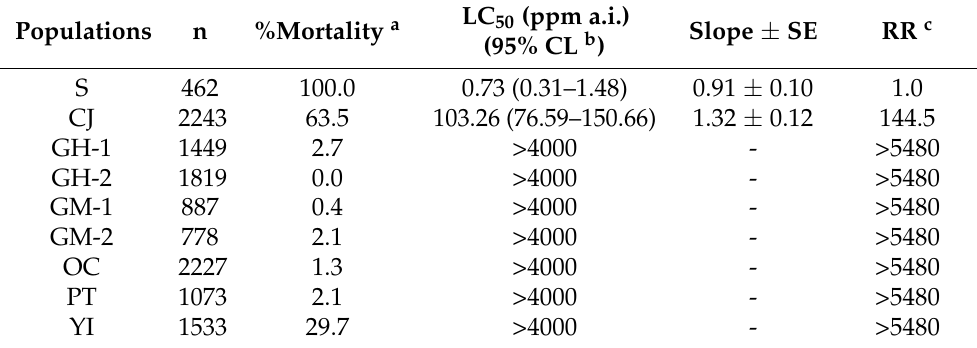
Table 9. Toxicity to pyridaben in susceptible and field-collected populations of T. urticae